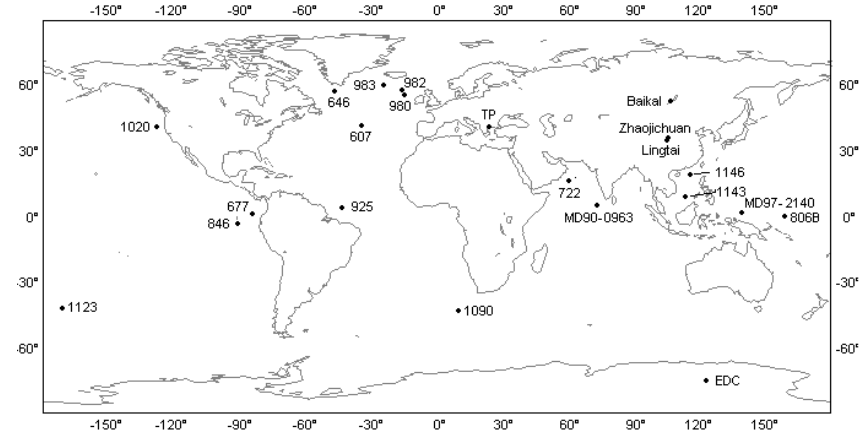
Fig. 1. Location of palaeoclimate records included in this